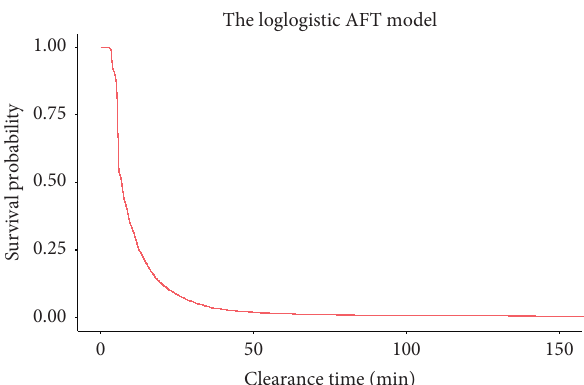
Figure 3: Estimated survival probability for the log-logistic AFT model.